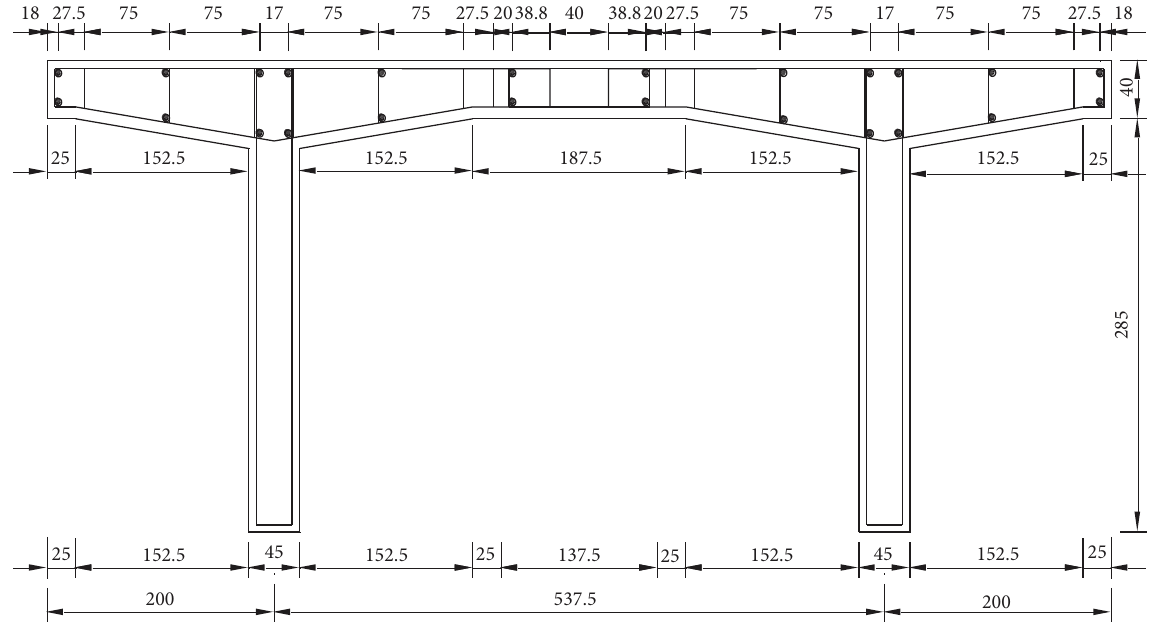
Figure 1: Structural dimension and reinforcement drawing the of carriageway slab (unit: mm).